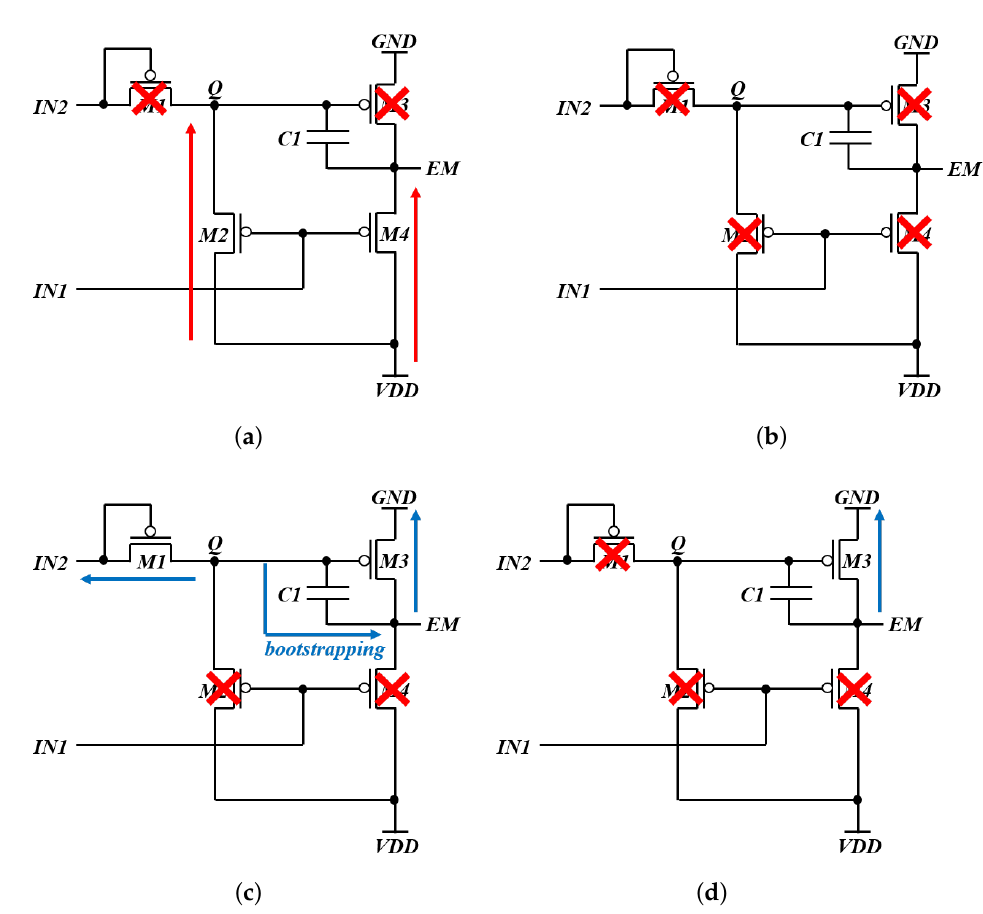
Figure 8. Four periods of the proposed EM circuit: ( a ) pulling-up ; ( b ) holding-high ; ( c ) bootstrapping ; and ( d ) holding-low